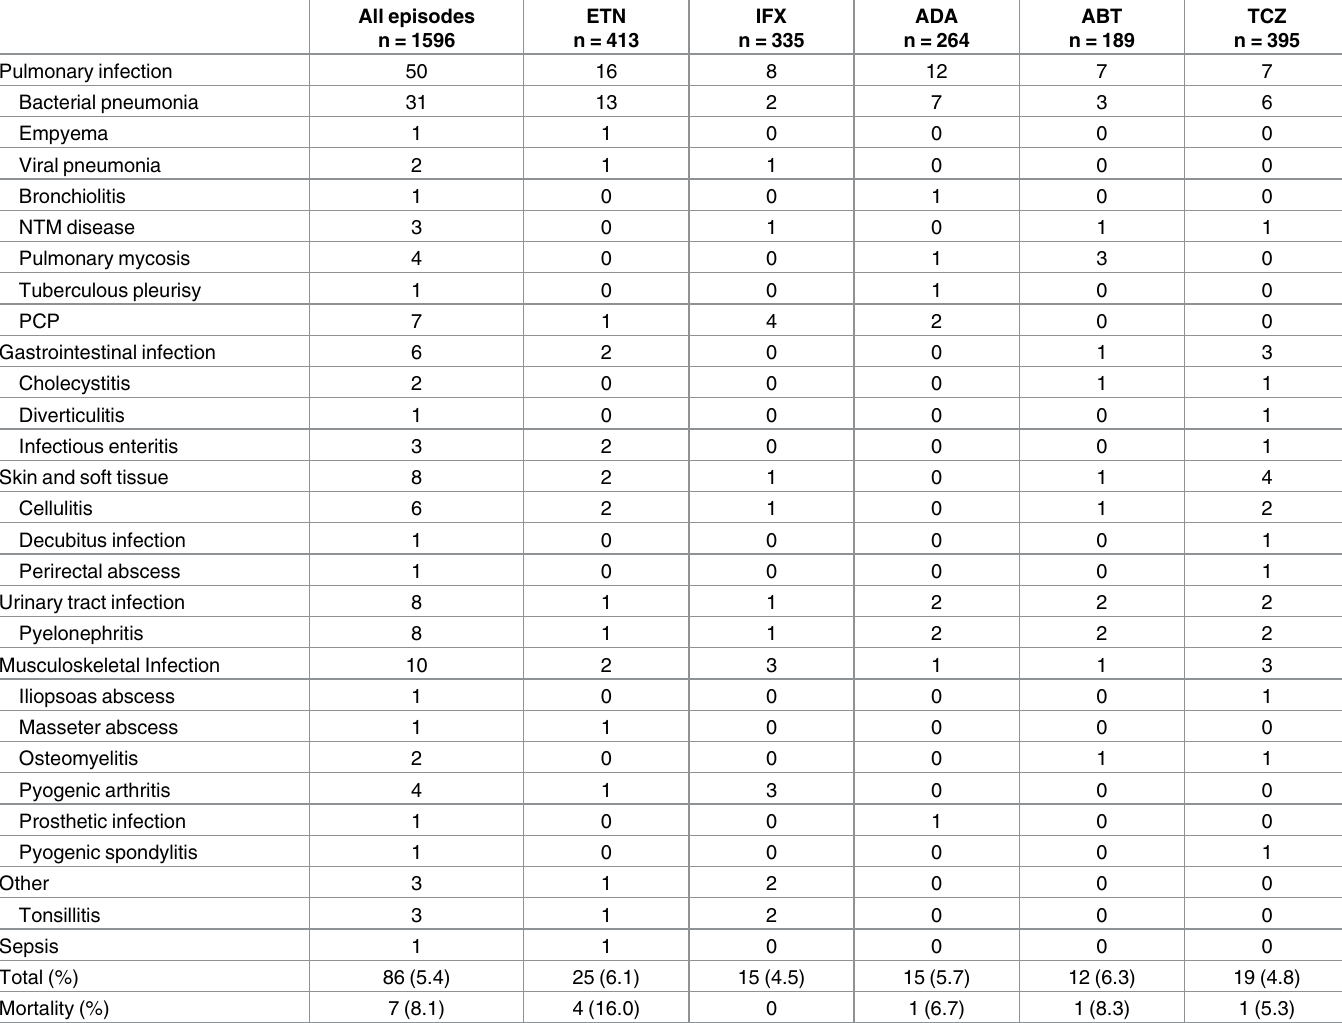
Table 2. Type, number, and mortality associated with hospitalized infections during the first year of follow-up to biological therapy for